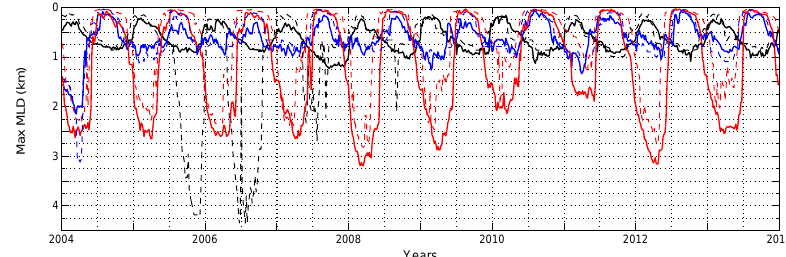
Figure 7. Time series of modelled mixed layer depth (MLD) maxima (in kilometres) in the North Atlantic Ocean (red), the Nordic Seas (blue), and the Southern Ocean (black) from GLOB16 (solid lines) and GLOB4 (dashed).